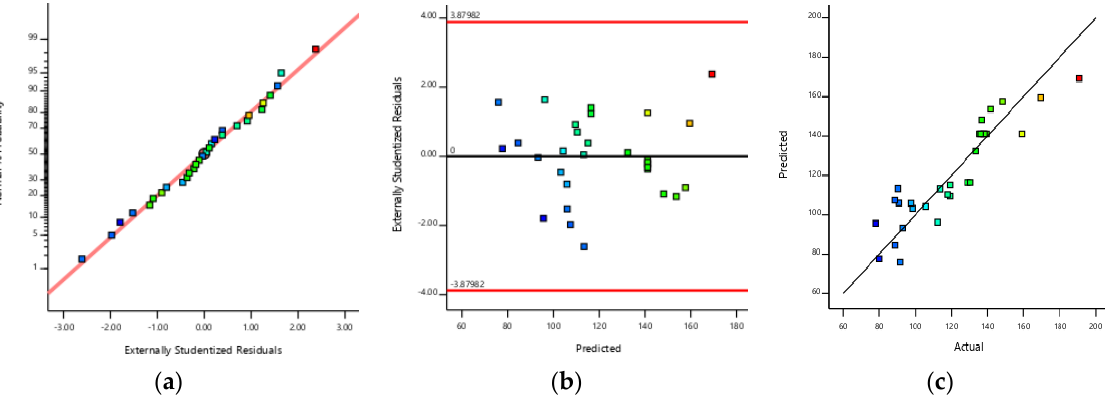
Figure 10. Residual diagnostic map of the secondary model of straw outer bark. ( a ) Normal plot of residuals; ( b ) residuals vs. predicted; and ( c ) predicted vs. actual.